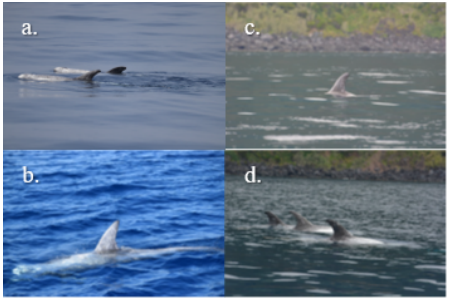
Figure 3. Images taken from the dataset. ( a , b ) Images have been captured in the Gulf of Taranto, ( c , d ) in the Azores islands.